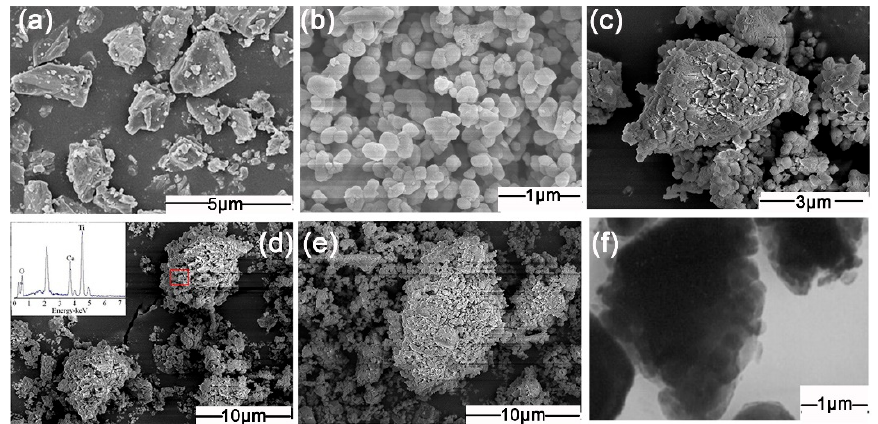
Figure 1. Scanning electron microscopy (SEM) and transmission EM (TEM) images of CaCO 3 , TiO 2 , and CaCO 3 -TiO 2 . ( a ) SEM image of CaCO 3 ; ( b ) SEM of TiO 2 ; ( c – e ) SEM image of CaCO 3 -TiO 2 with TiO 2 mass ratio of 30%, 40%, and 50%; ( f ) TEM of CaCO 3 -TiO 2 (50%).